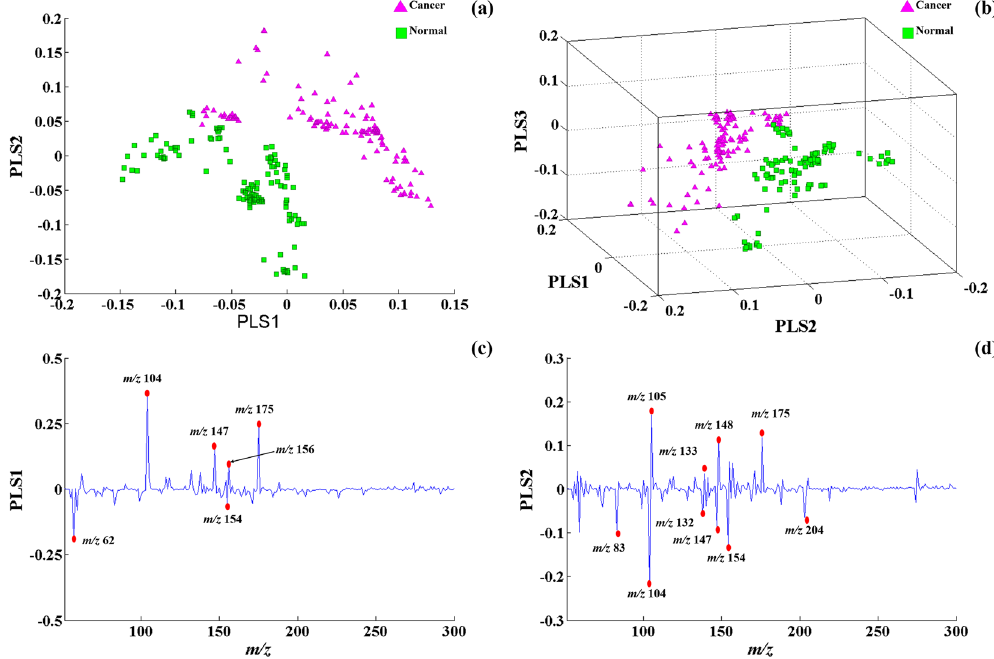
Figure 2. PLS analysis of oesophageal tissue mass fingerprinting. ( a ) Score plots for PLS1 and PLS2; ( b ) A 3D model to distinguish oesophageal cancer tissue from normal tissue; ( c ) Loading plots for PLS1 in PLS from the training set. ( d ) Loading plots for PLS2 in PLS from the training set. The plots illustrate the m/z values and their relative importance in the PLS analysis.